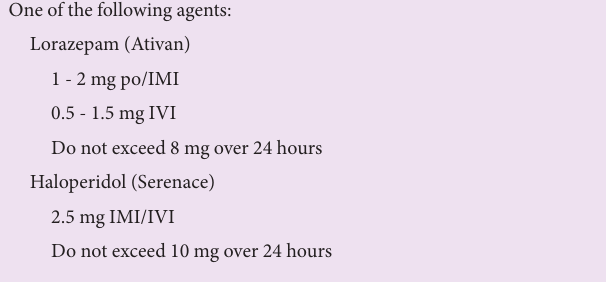
Table 6. Psychotropics for acute sedation [10] One of the following agents: Lorazepam (Ativan) 1 - 2 mg